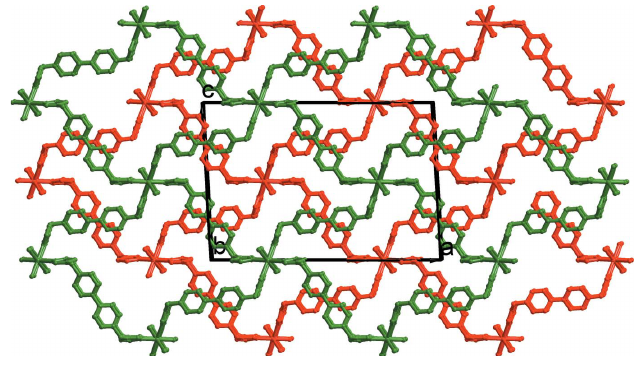
Figure 3 The packing of the title compound viewed along the b axis. H atoms are omitted for clarity.